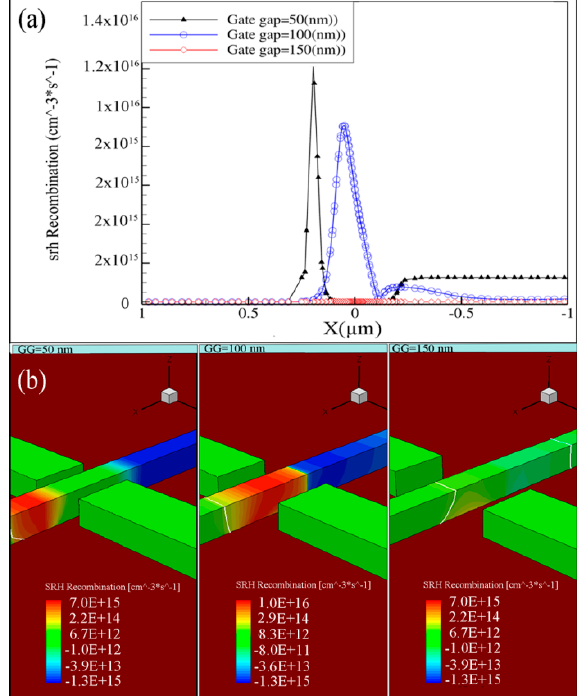
Figure 10. ( a ) The SRH recombination–generation rate along a cutline at Z = 50 nm and ( b ) a bird eye view for devices with different gate gap at V G = +2 V and V D = − 1